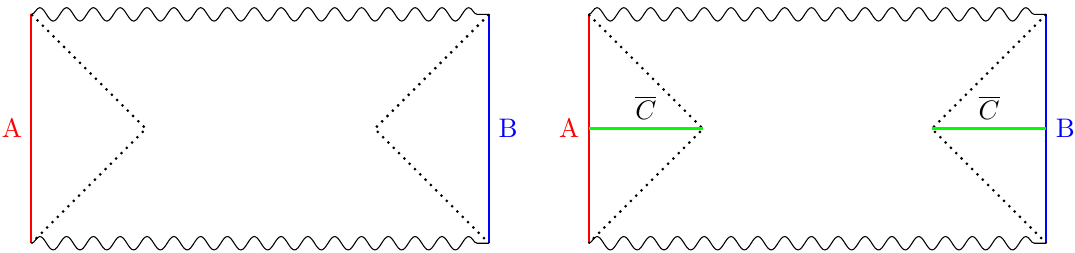
Figure 3 . Left : the Penrose diagram of the new spacetime A/B in AdS. The spacetime is specified by the left and right conformal boundary conditions (red and blue vertical lines). Right : the same Penrose diagram of the new spacetime A/B with the region C (green region) on which we evaluate the generalized entropy S gen [ C ]